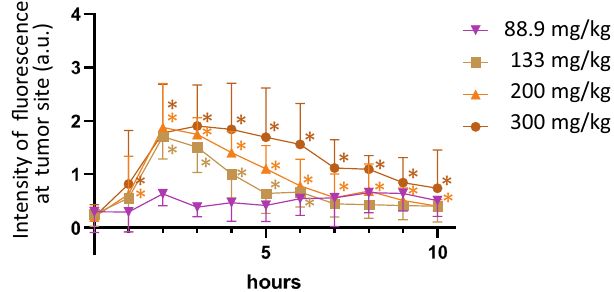
Figure 2. Temporal changes of relative fluorescence intensity for PPIX at tumor sites. ALA dose was 88.9, 133, 200 or 300 mg/kg per animal (n = 5 each). *; p < 0.05 compared to fluorescence values at 0 h for each curve.